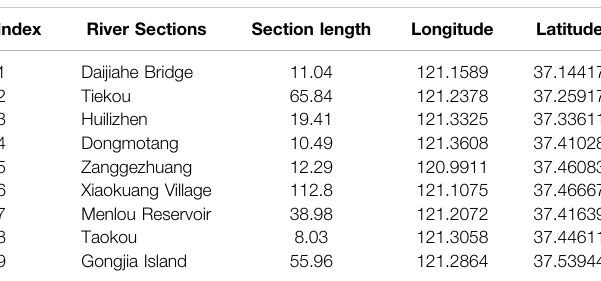
TABLE 3 | Section division of the Diagujia